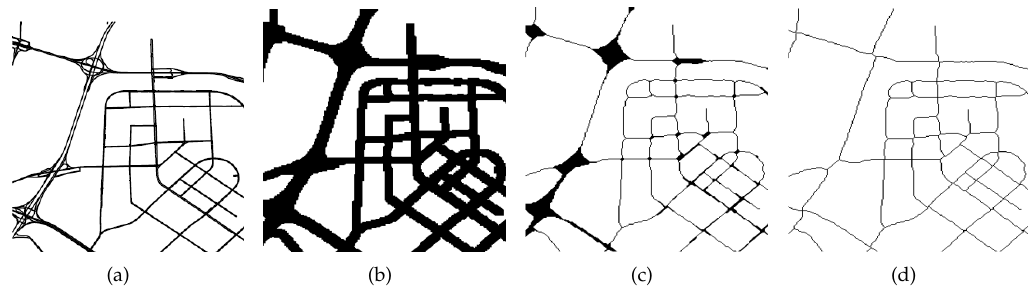
Figure 3. Procedure of segment maps. ( a ) Source binary image; ( b ) Binary image after dilation. ( c ) Binary image after thinning; ( d ) Final segmented